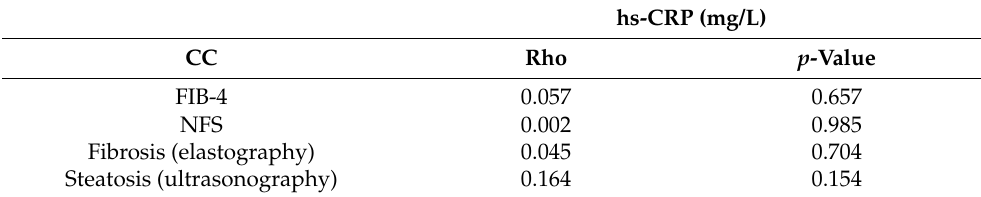
Table 3. Relationship between baseline hs-CRP and liver status after bariatric surgery.